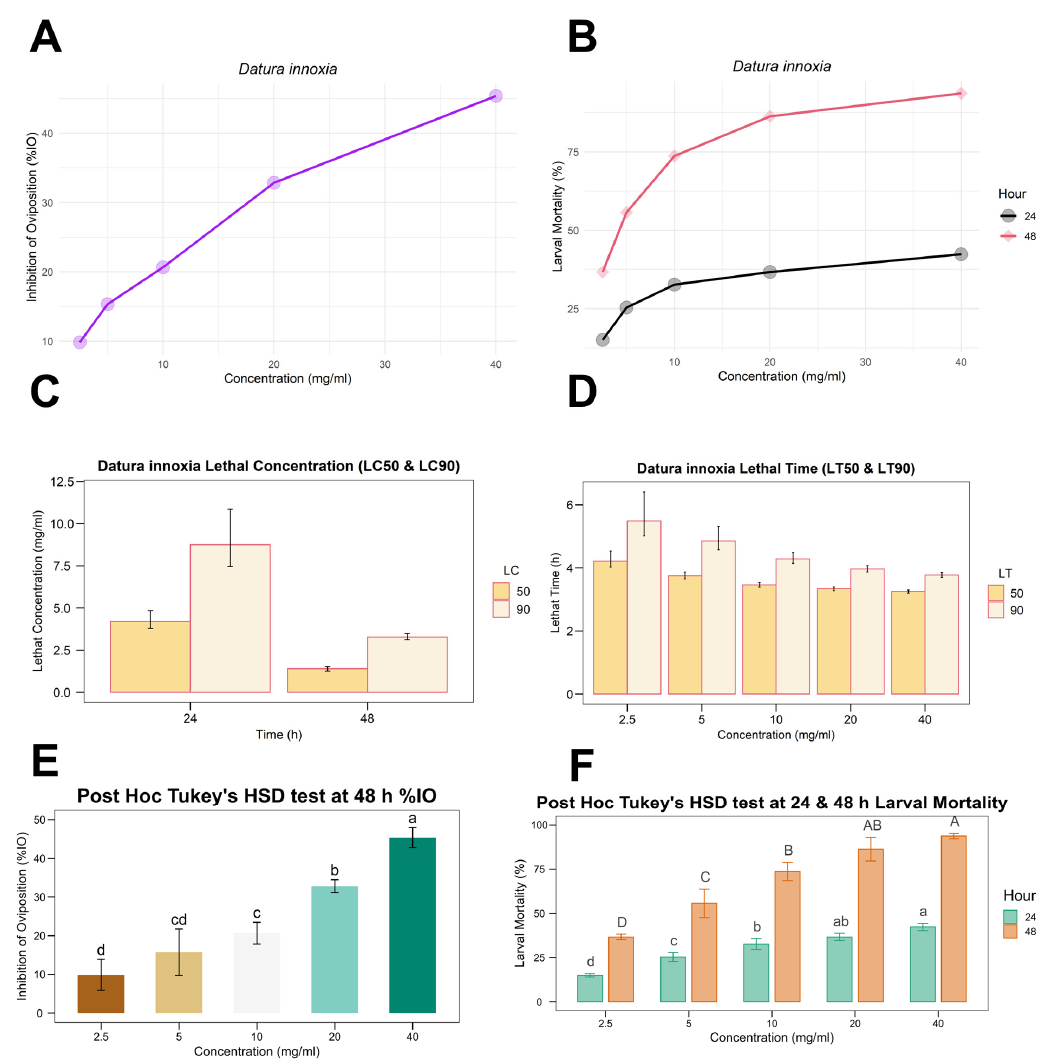
Figure 1. ( A ) Response curve graph for the inhibition of oviposition (% IO in AIT) at 48 h; ( B ) concentration–mortality curve for larval mortality at 24 and 48 h in LPT; ( C , D ) represent log- transformed LC 50 , LC 90 , LT 50 , and LT 90 with error bars showing the corresponding log-transformed lower and upper confidence limits values of the LC and LT in LPT; ( E , F ) represent one-way ANOVA with post hoc Tukey HSD test for % IO and larval mortality, for AIT and LPT,